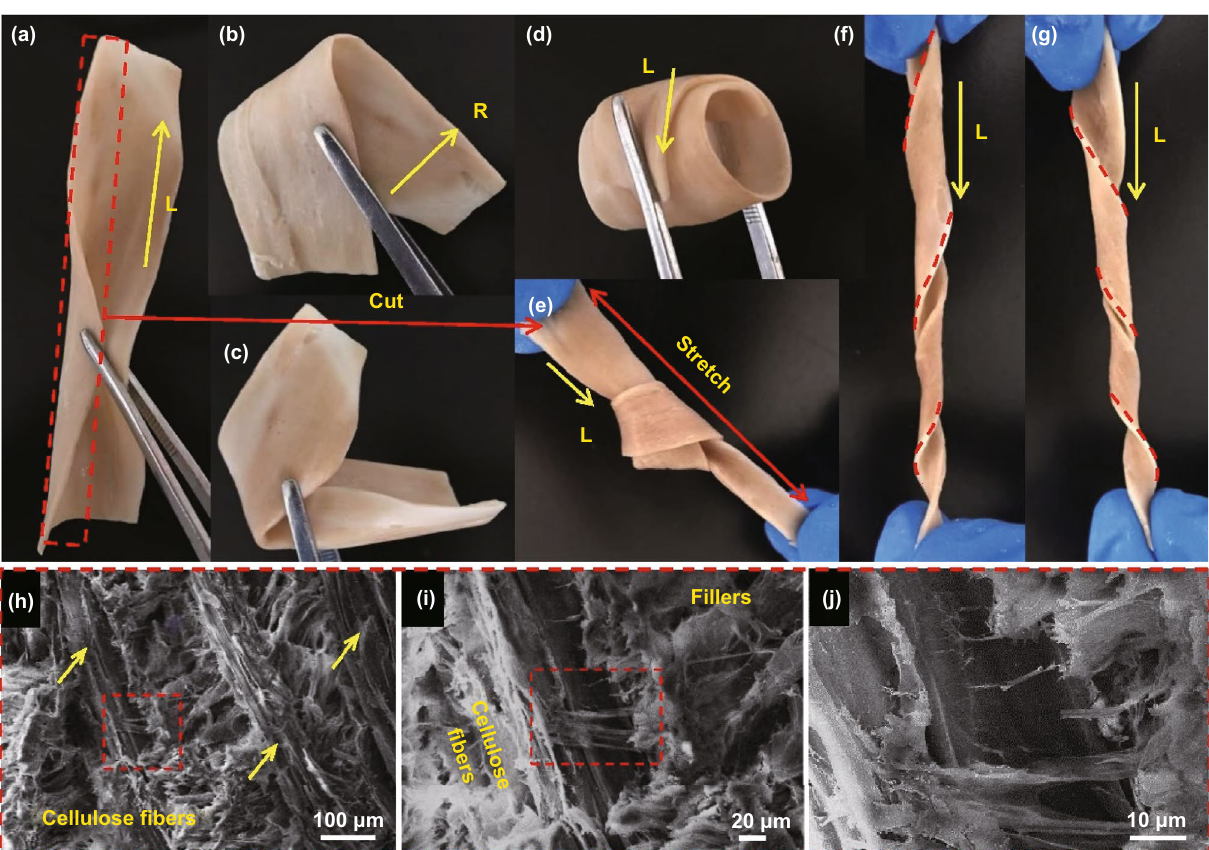
Fig. 4 Digital images of the all-wood hydrogel (1 mm thick) folded in the a radial direction, b longitudinal direction, c in random directions, d wrapped, e stretched in the knotted case and curled to the f right and g left along to the longitudinal direction. h‑j SEM images showing the cross-linking of all-wood hydrogels. Note that the cellulose nanofibers are tightly cross-linked to each